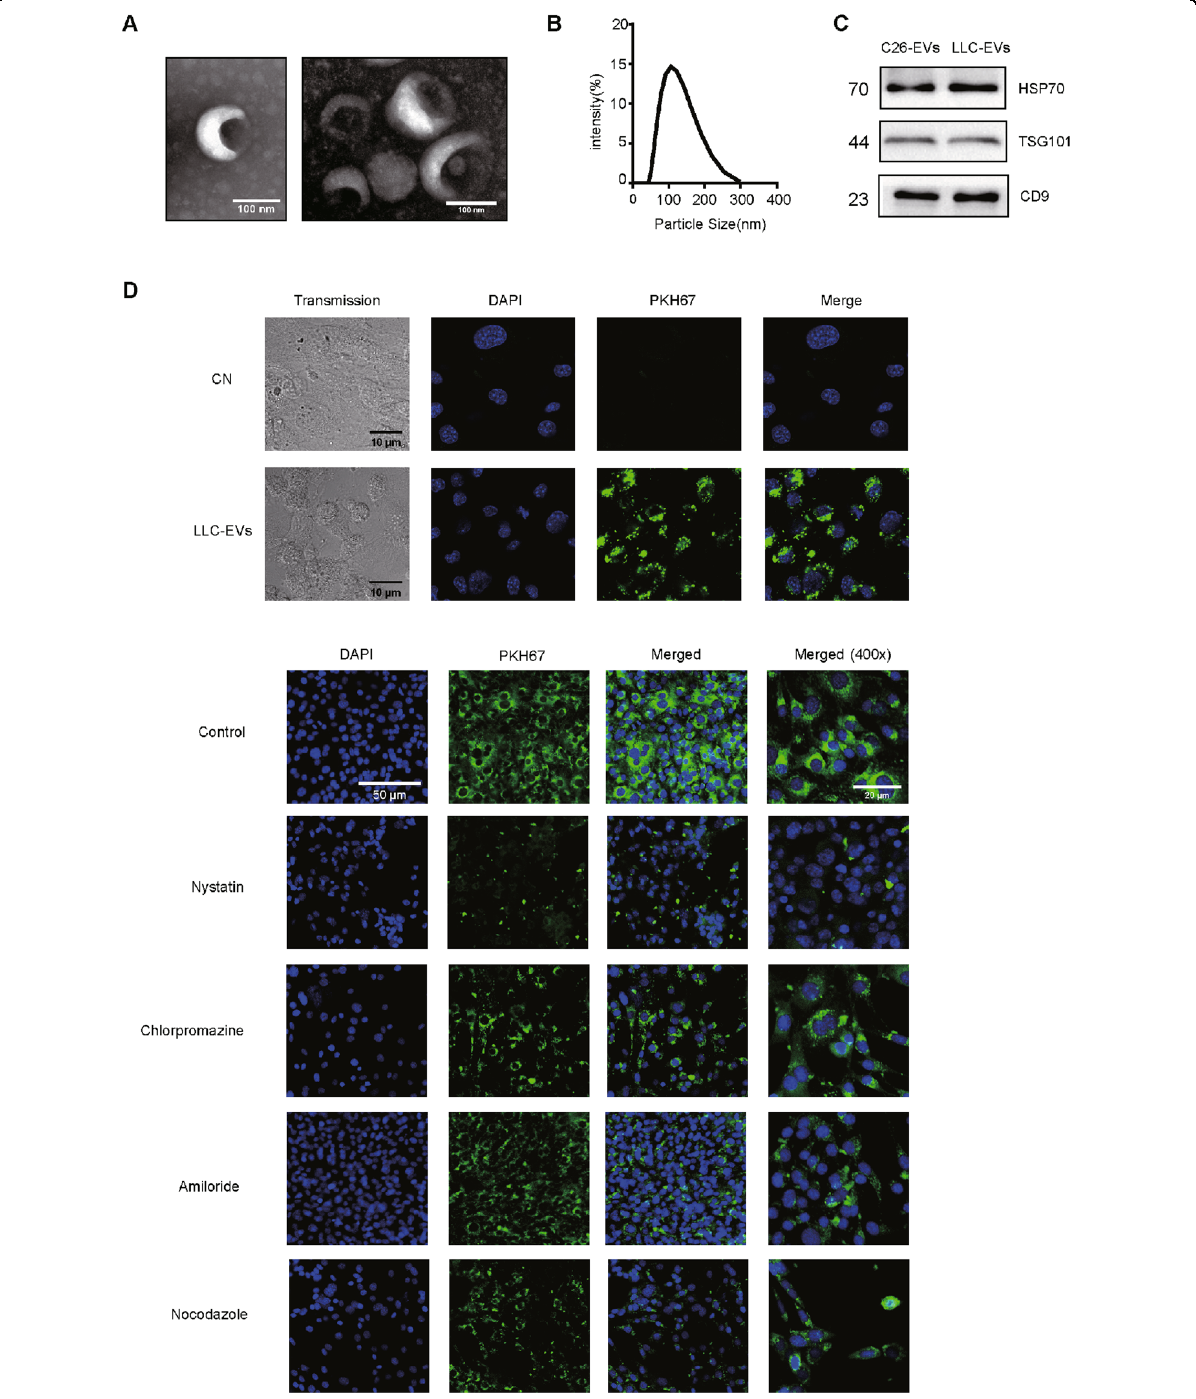
Fig. 1 Analysis of LLC-EV characteristics. A Analysis of EVs by electron microscopy (bars = 100 nm). B Size of LLC-EVs isolated from LLC cells (mean diameter: 109 nm). C Western blotting analysis of the expression of Hsp70, TSG101, and CD9 in EVs isolated from C26 and LLC cells. D Confocal images (20×) of differentiated adipocytes pretreated with various inhibitors of endocytic pathways and incubated with labeled LLC-EVs for overnight at 37 °C. Amiloride (50 μ M; 30 min), nystatin (54 μ M; 30 min), chlorpromazine (20 μ M; 30 min), and nocodazole (1 μ M; 10